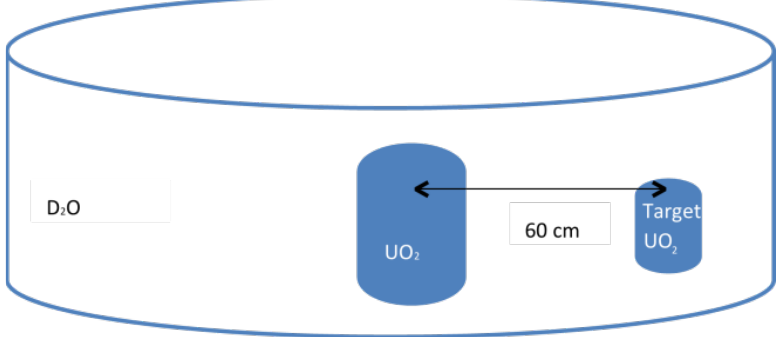
Figure 1. Visual representation of reactor model to show target location. Table 1. Material compositions of targets.